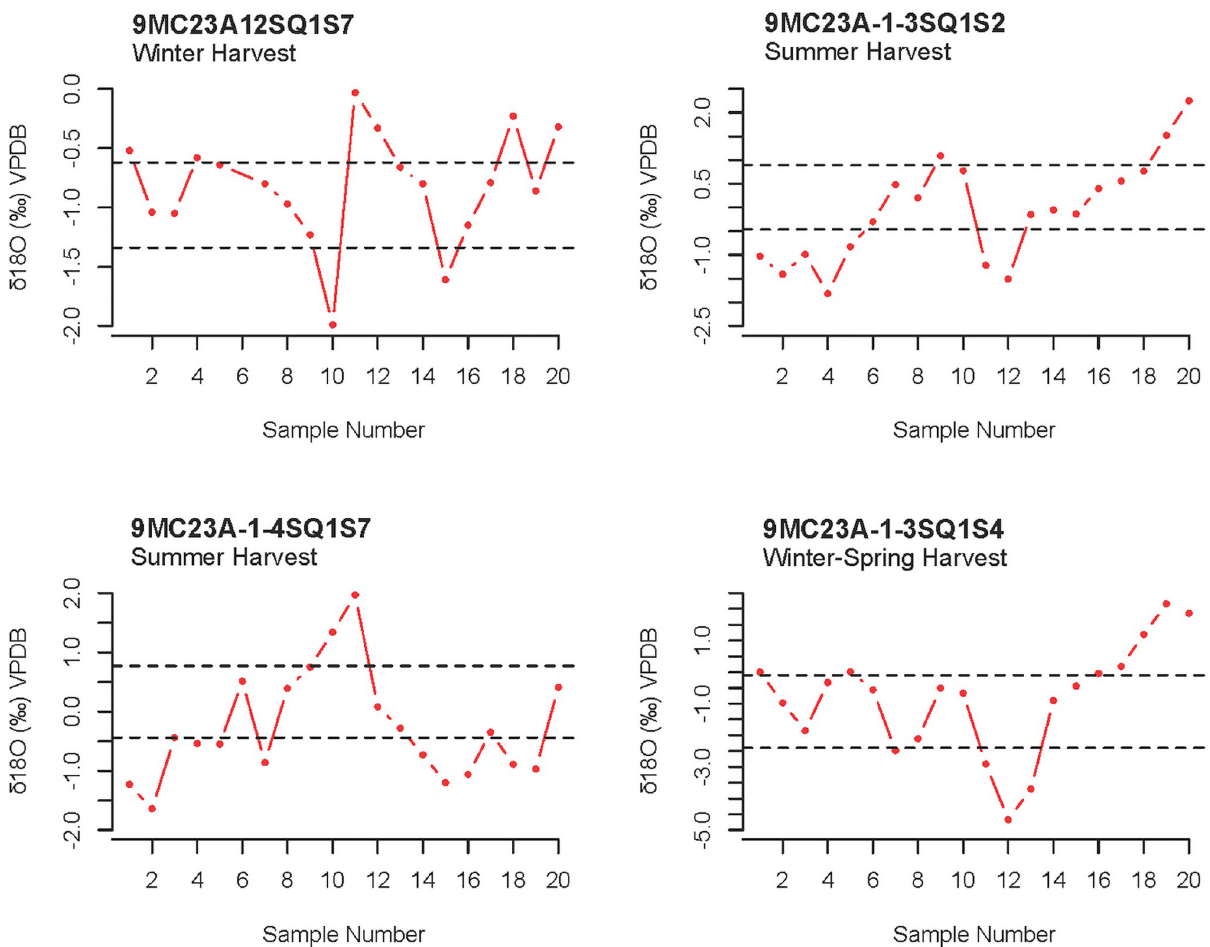
Fig 4. Examples of individual shell δ 18 O carbonate profiles showing seasonal fluctuations in oxygen values and estimated season of harvest. The data sequence follows ontogeny from right to left, with the first value representing time of capture. The dashed lines in each graph represent the values that divide the sample range for each profile into equal thirds. If the first sample value falls below the bottom line the shell was collected in the summer, and if it falls above the top line then the shell was harvested in the summer. If the first value falls between the lines, then the shell was harvested in either the fall or spring.